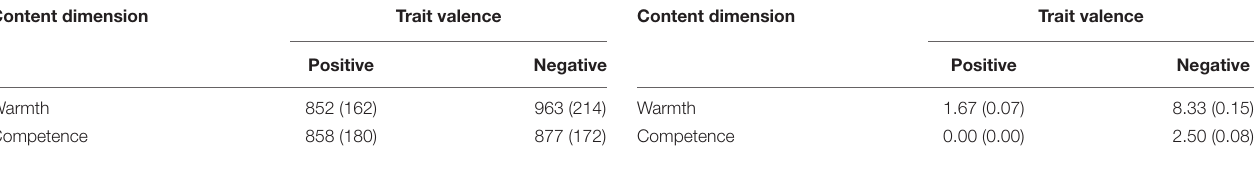
TABLE 2 | Mean (SD) reaction times to the key trait probe by content dimension and valence. Content dimension